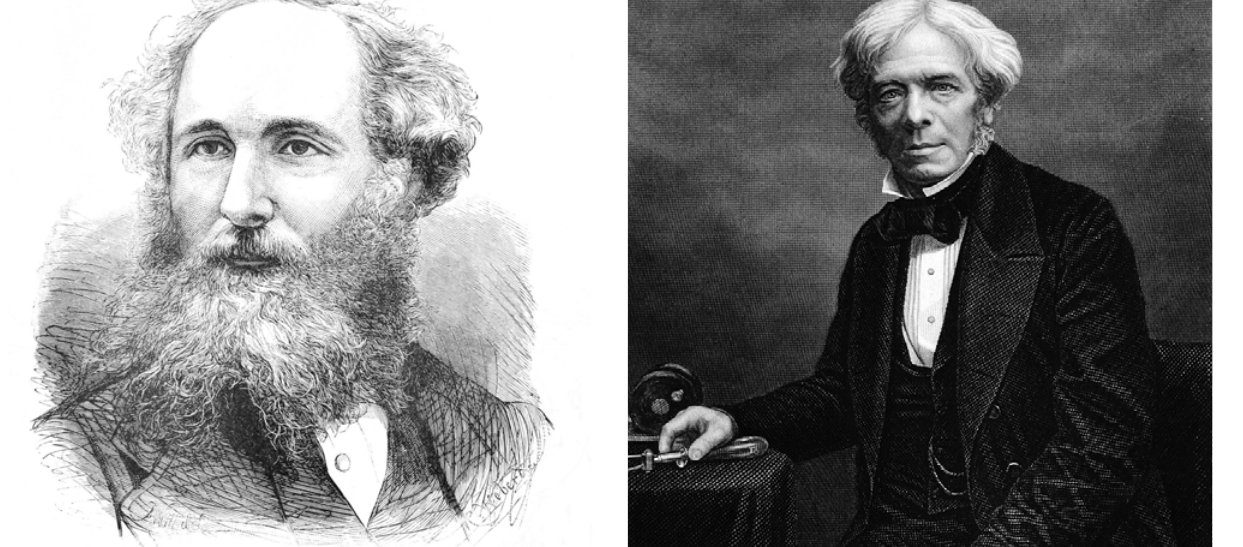
Figure 11. Michael Faraday in his sixties